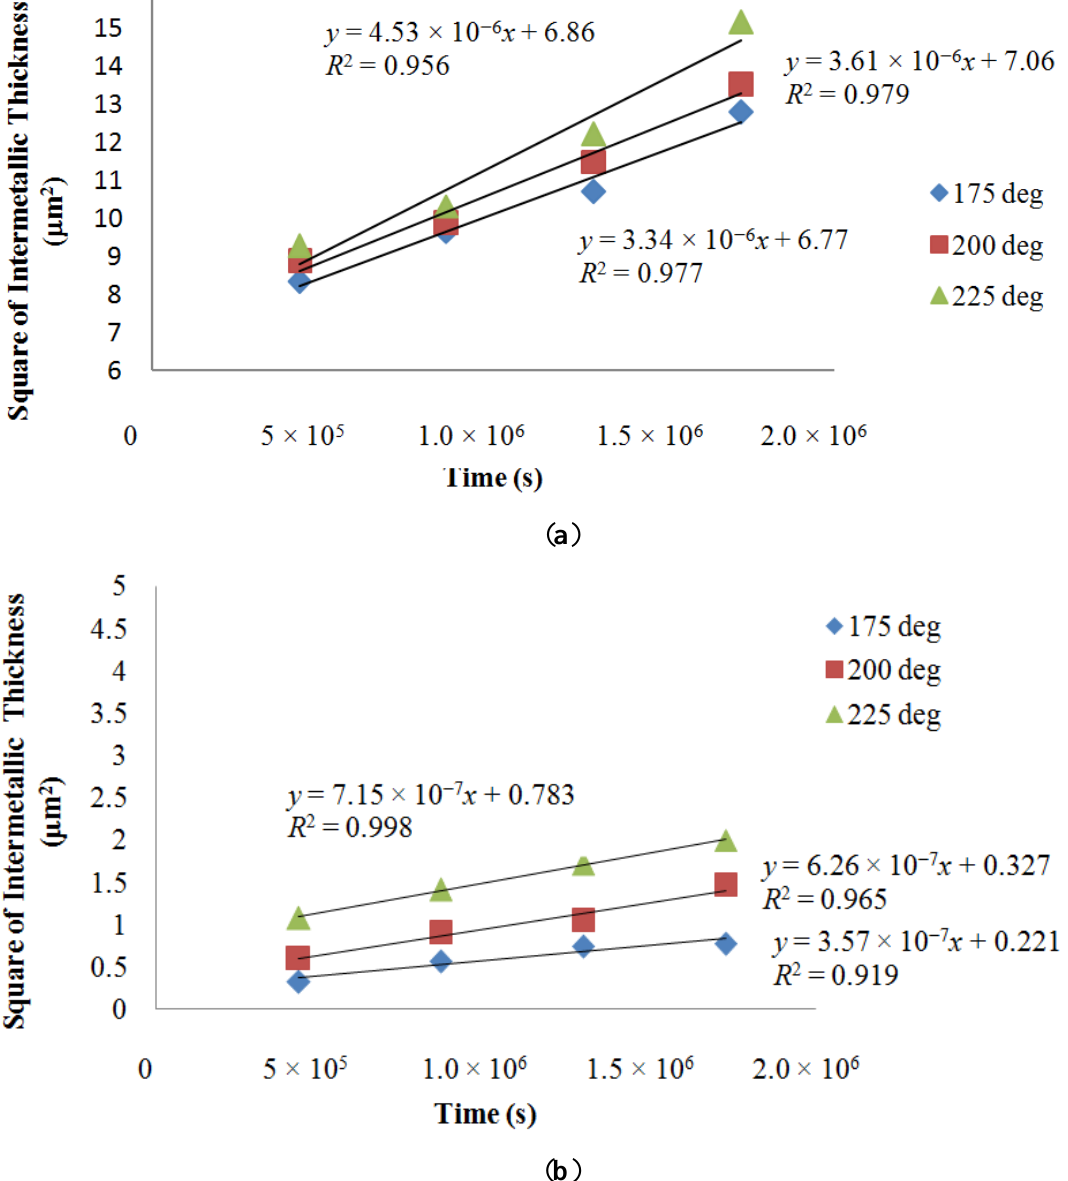
Using the K at three different temperatures, graphs of lnK vs . 1/T are plotted for Au and